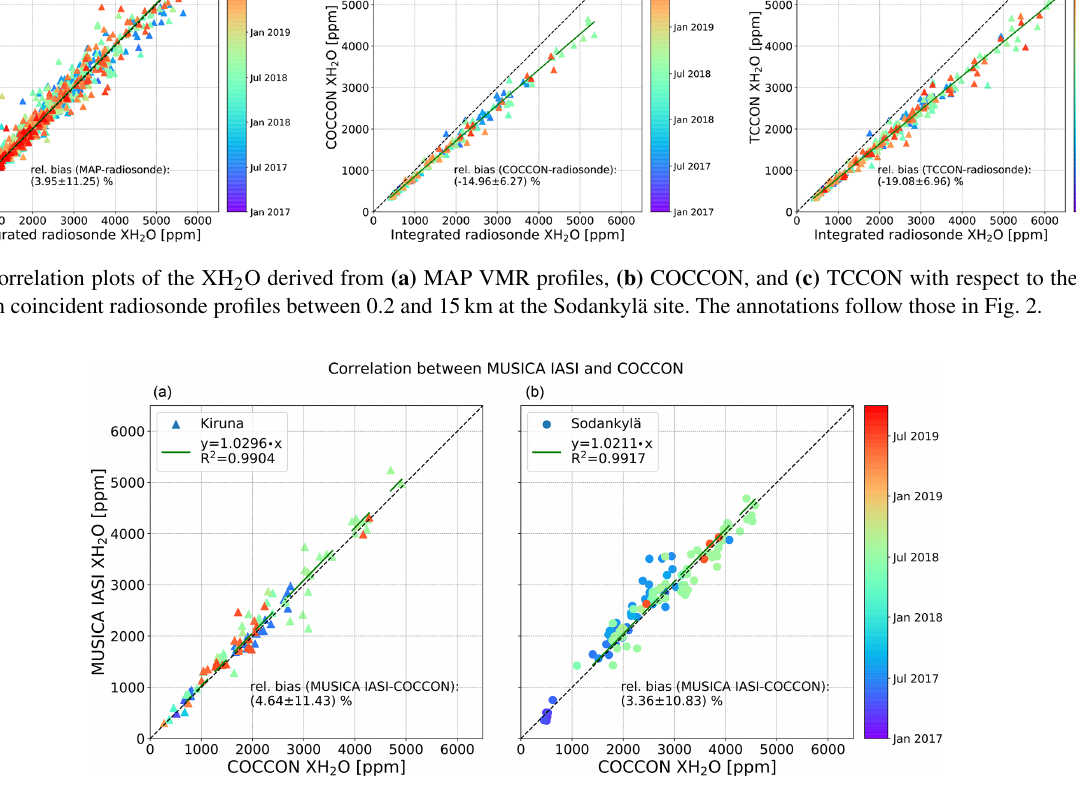
Figure 10. Scatterplot of the COCCON XH 2 O compared with coincident MUSICA IASI retrievals at the Kiruna site (a) and the Sodankylä site (b) . The annotations follow those in Fig.